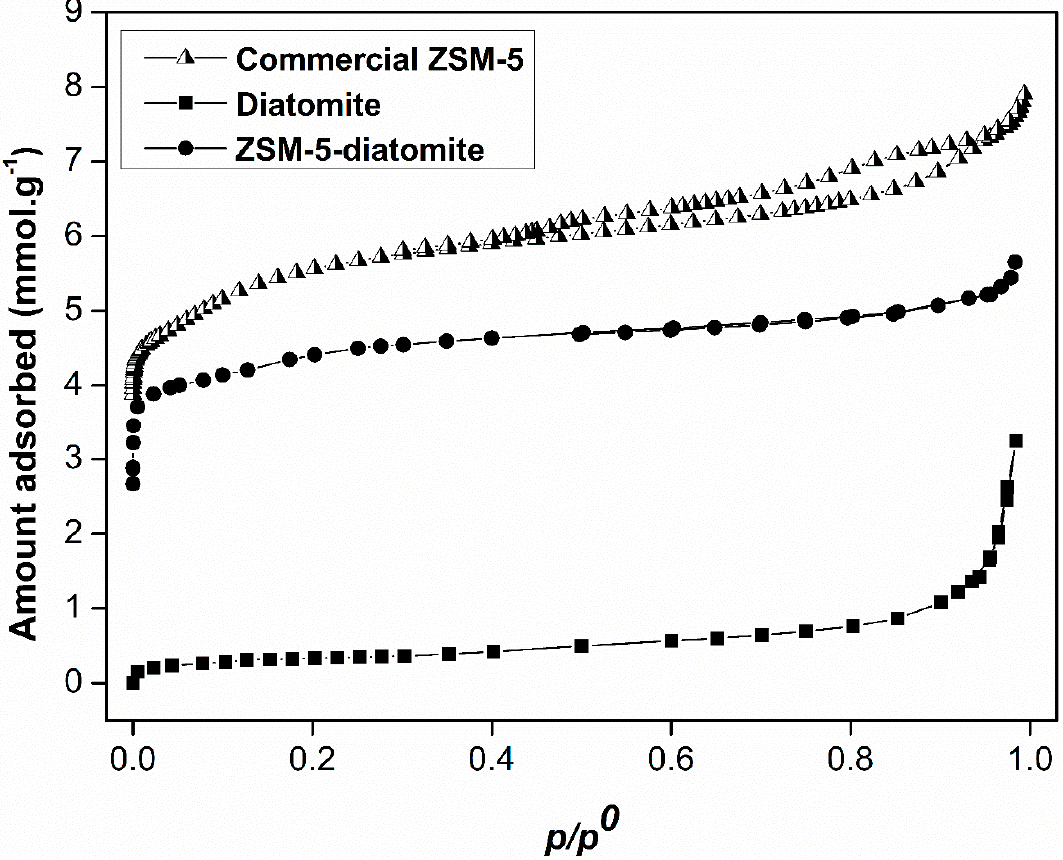
Figure 5. Nitrogen adsorption / desorption isotherms for the diatomite, the commercial ZSM-5 and the synthesized ZSM-5-diatomite samples. The raw material presented a Type II isotherm, meanwhile the zeolites showed Type I isotherms.